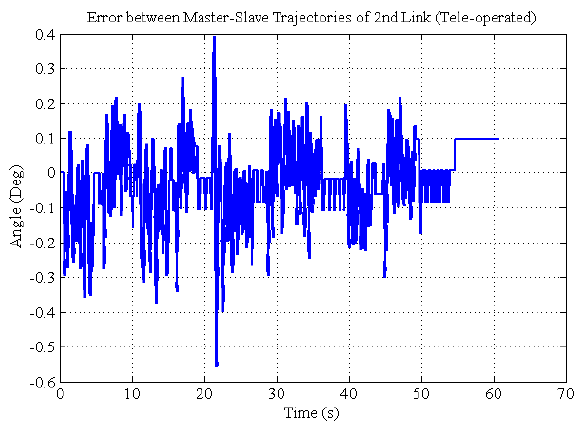
Figure 16. Error between master and slave trajectories for the 2 nd link.